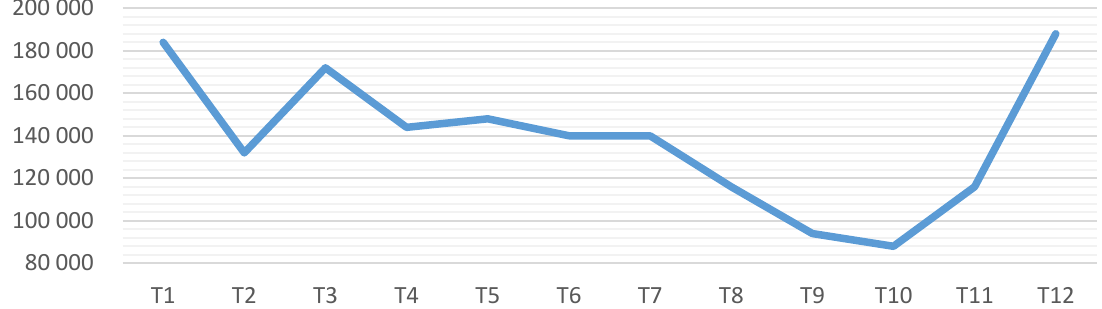
Figure 5. Coffee production in Vietnam in 2019